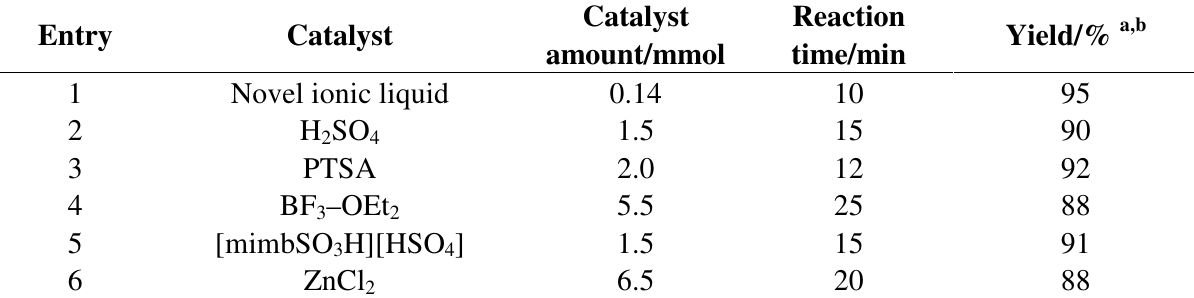
Table 3. The comparison of different